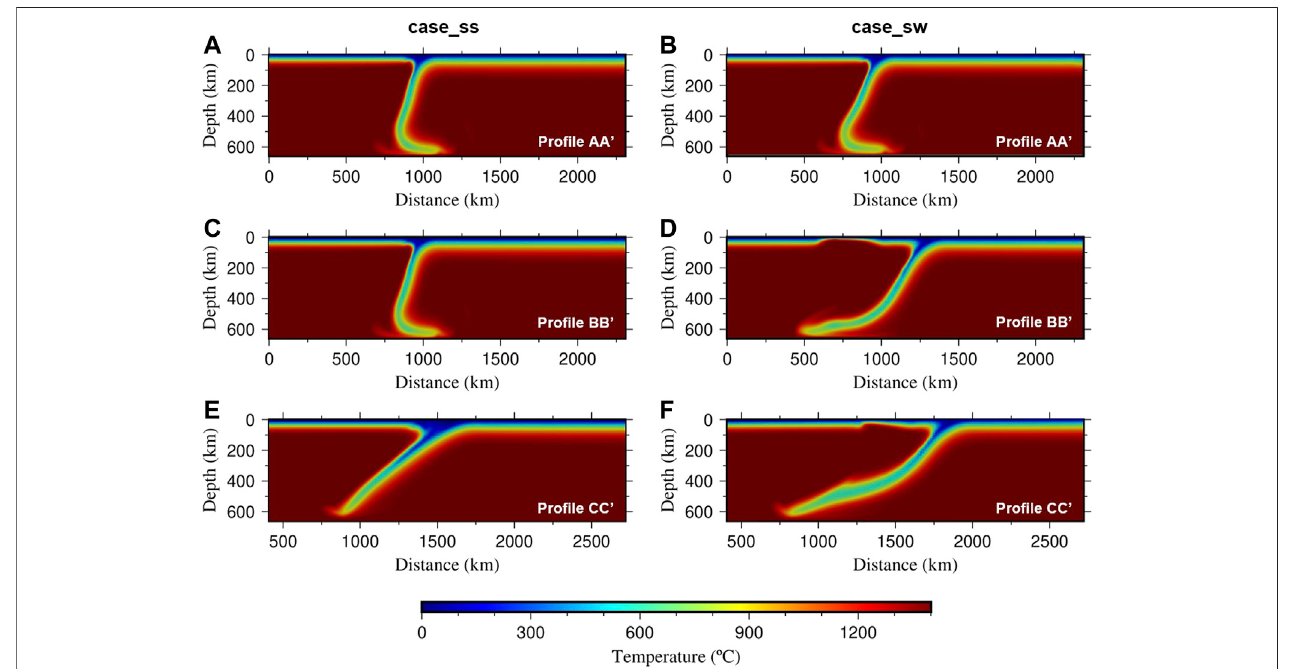
FIGURE 6 | Temperature fi eld along the pro fi les of AA ’ , BB ’ , and CC ’ at 12.15 Myr in case_ss (A – E) and case_sw (B – F) . The locations of the AA ’ , BB ’ , and CC ’ pro fi les are shown in Figure 2A .